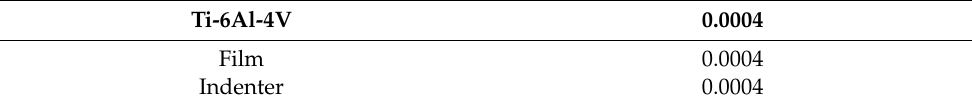
Table 3. Mesh size setting